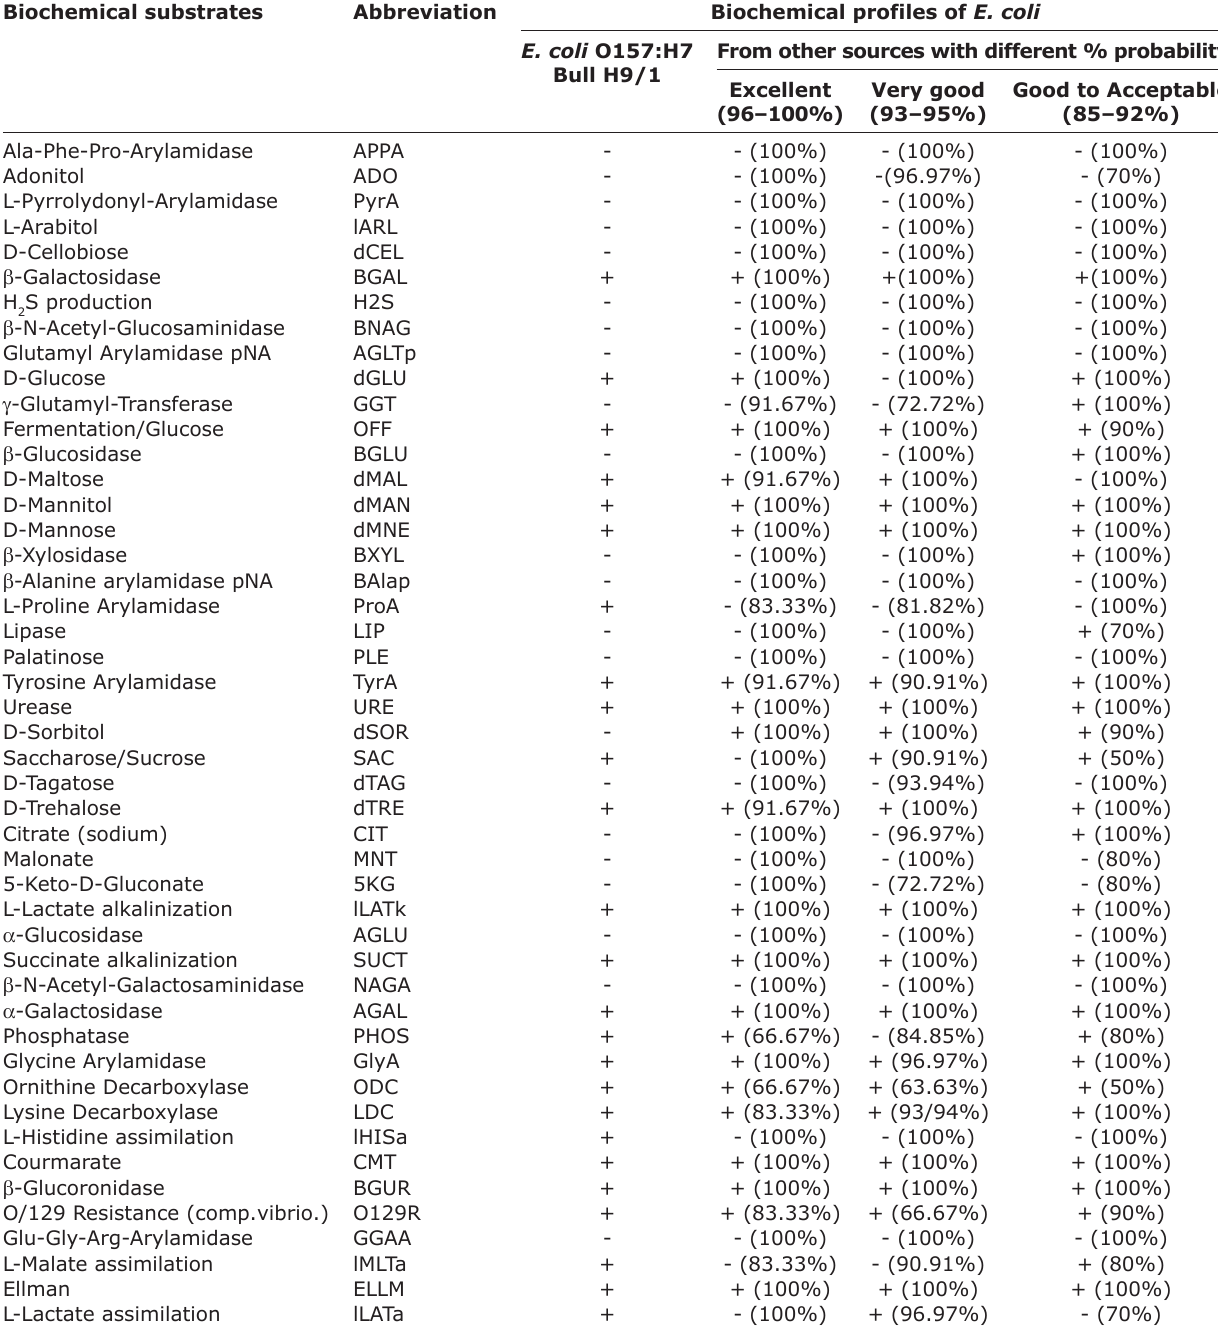
Table-3: The biochemical profiles of E. coli O157:H7 Bull H9/1 compared to E. coli from other samples. Biochemical